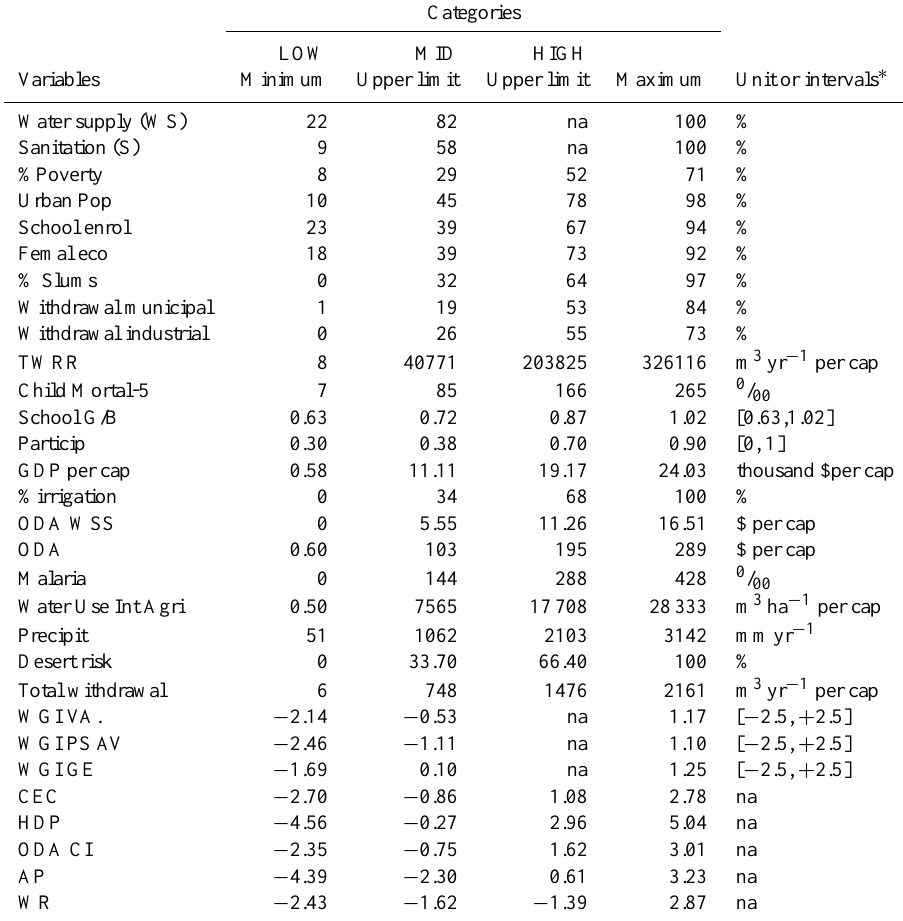
Table A1. Limits of variable categories, high, mid, low.